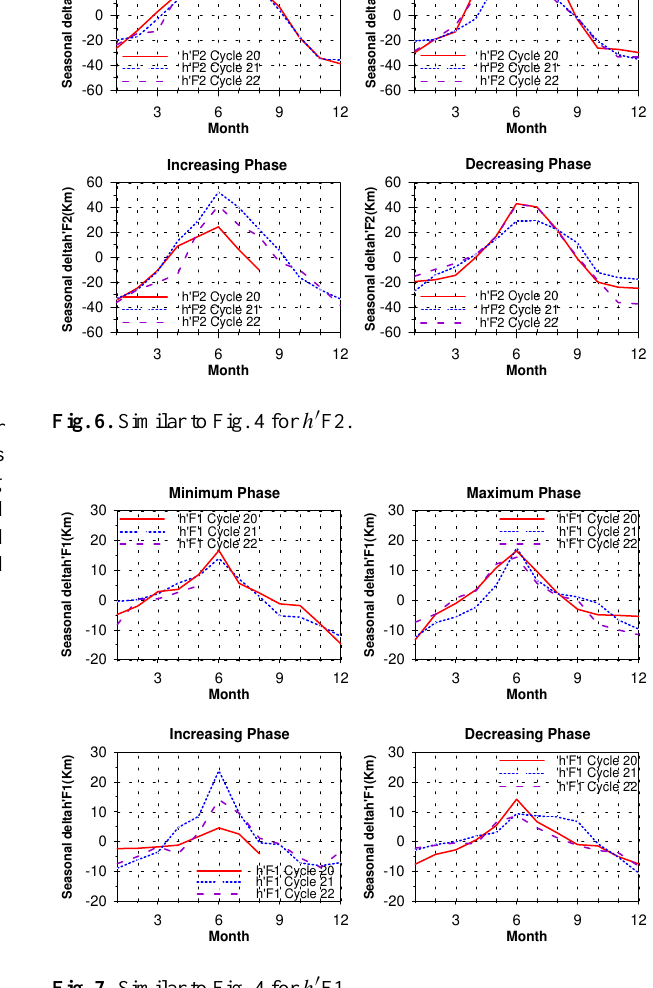
Fig. 7. Similar to Fig. 4 for h 0